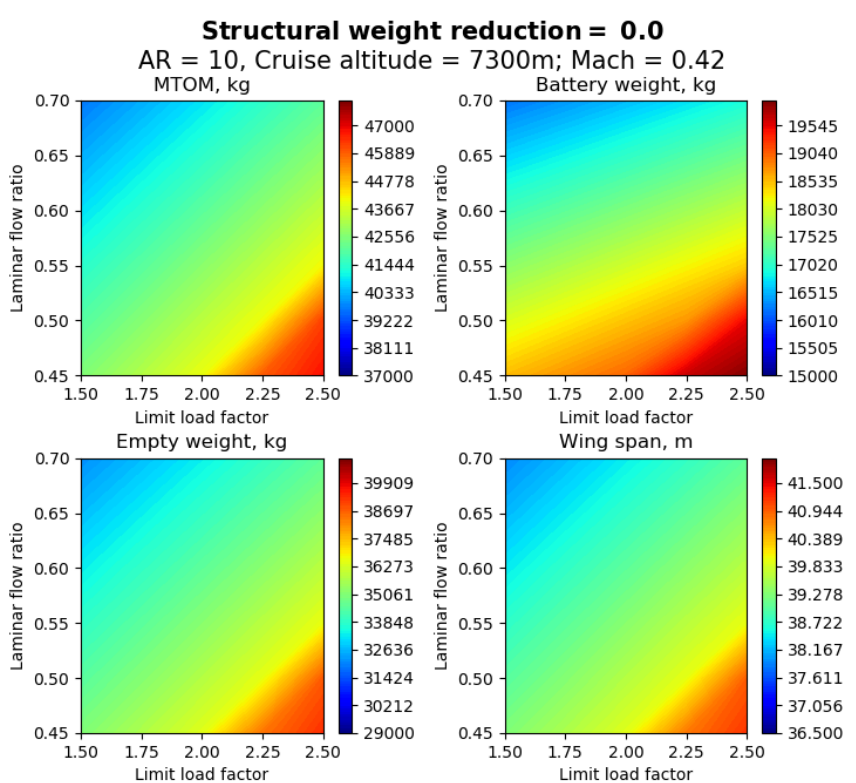
Figure 17. Sensitivity of aircraft characteristics to changes in technology levels at Structural weight reduction of